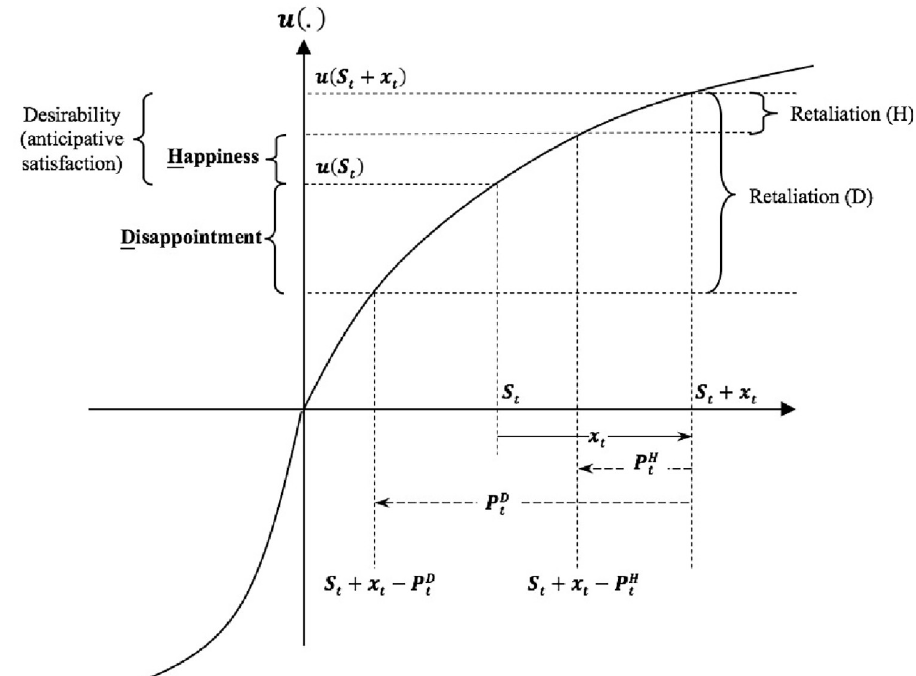
Fig 1. State variables of AM under the S-shaped utility.